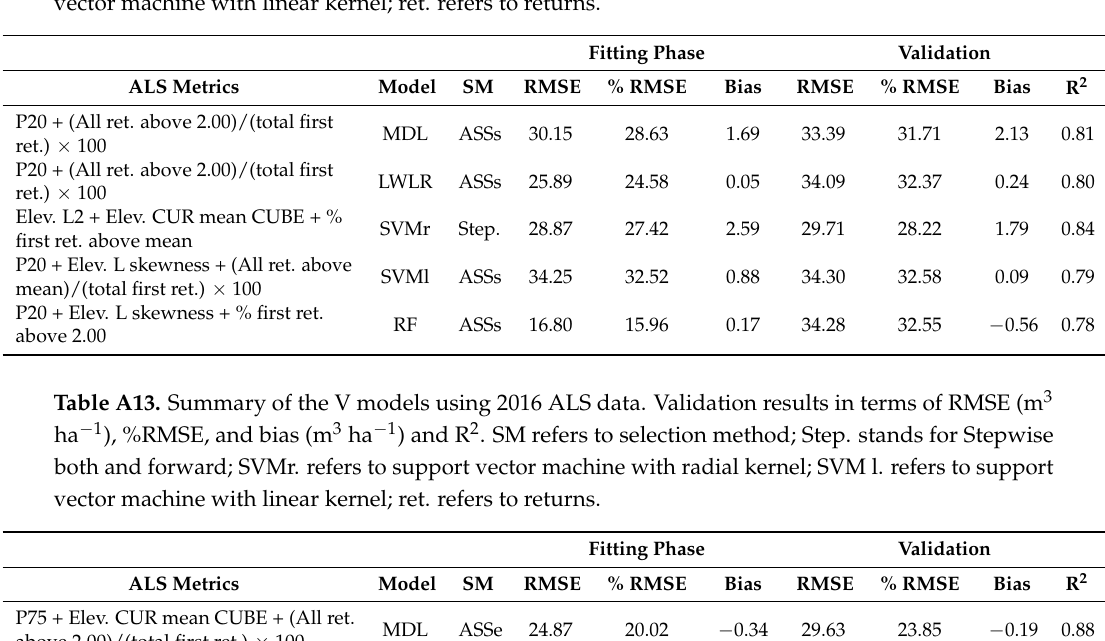
Table A12. Summary of the V models using 2011 ALS data. Validation results in terms of RMSE (m 3 ha − 1 ), %RMSE, and bias (m 3 ha − 1 ) and R 2 . SM refers to selection method; Step. stands for Stepwise both and forward; SVMr. refers to support vector machine with radial kernel; SVM l. refers to support vector machine with linear kernel; ret. refers to returns.